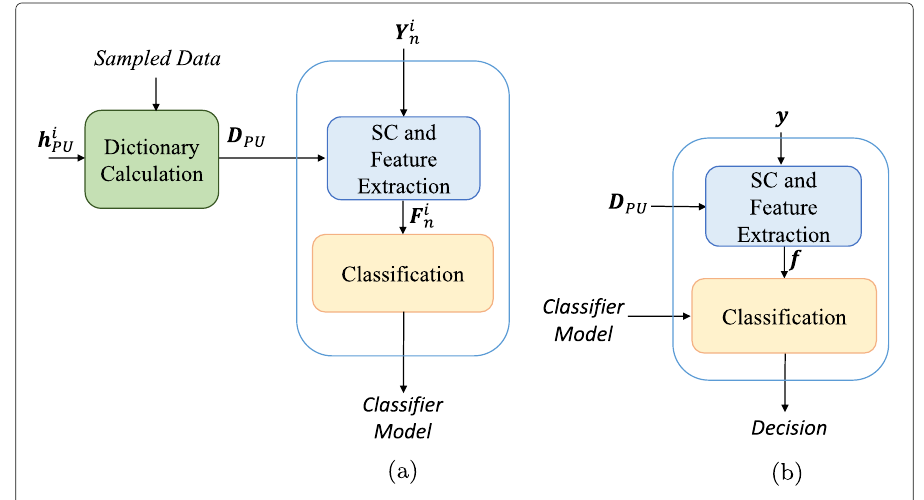
Fig. 3 An illustration of the proposed algorithm for ( a ) training stage and ( b ) testing